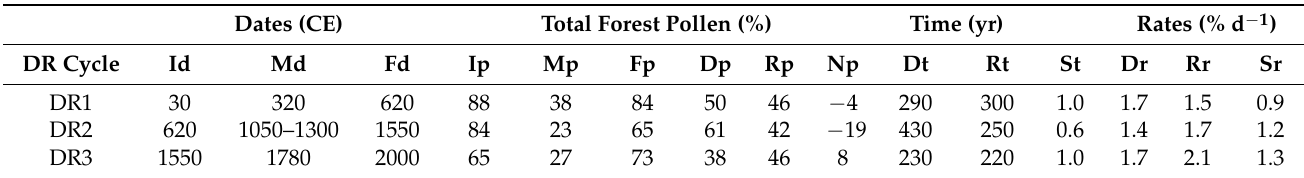
Table 1. Parameters used for comparisons among Roman (DR1), Medieval (DR2) and Modern (DR3) deforestation cycles in the Montcort è s region (raw data: https://data.mendeley.com/drafts/mr4h3 x7x35, (accessed on 6 March 2023). Dates (CE): Id, Initial date; Md, maximum deforestation date; Fd,